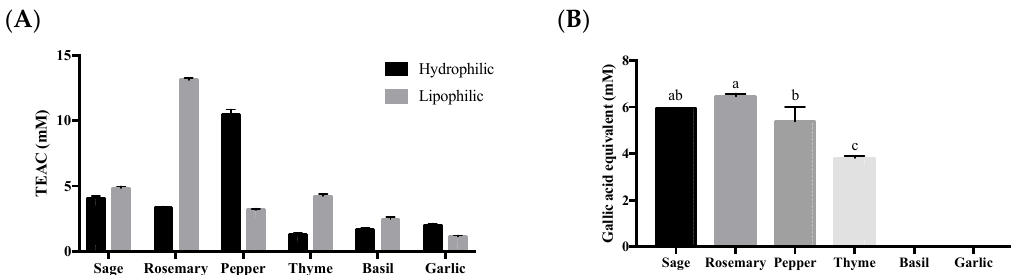
Figure 1. Antioxidant capacity ( A ) and total phenolic content of fresh condiment extract (1:1, hydrophilic: lipophilic) ( B ). Data presented are mean ± S.D. ( n = 3). Kruskal-Wallis (non-parametric ANOVA) test ranks black pepper and rosemary to be the highest in hydrophilic, and lipophilic extracts, respectively. Columns sharing different alphabets are significantly different at least p < 0.05.